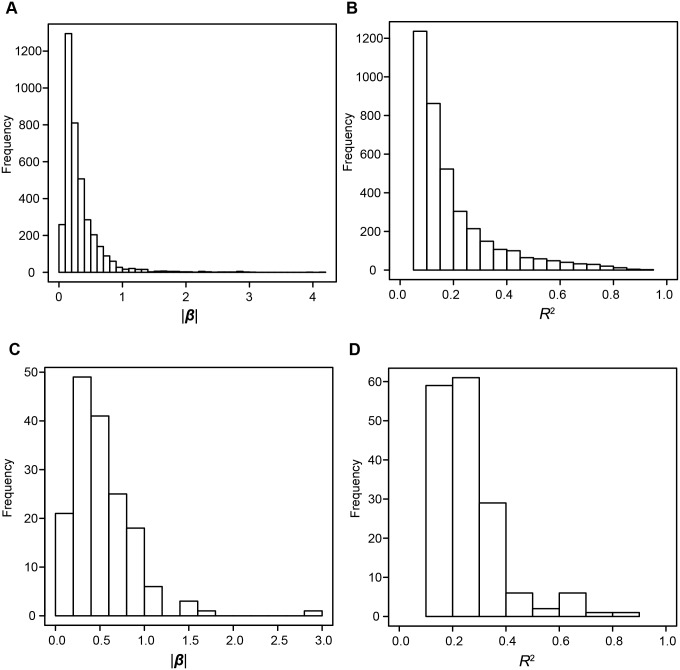
Histograms of effects of eQTLs.A, B) Histograms of |β| values (A) and of R
2 values (B) of cis-eQTLs are shown. C, D) Histograms of |β| values (C) and R
2 values (D) of trans-eQTLs are shown.